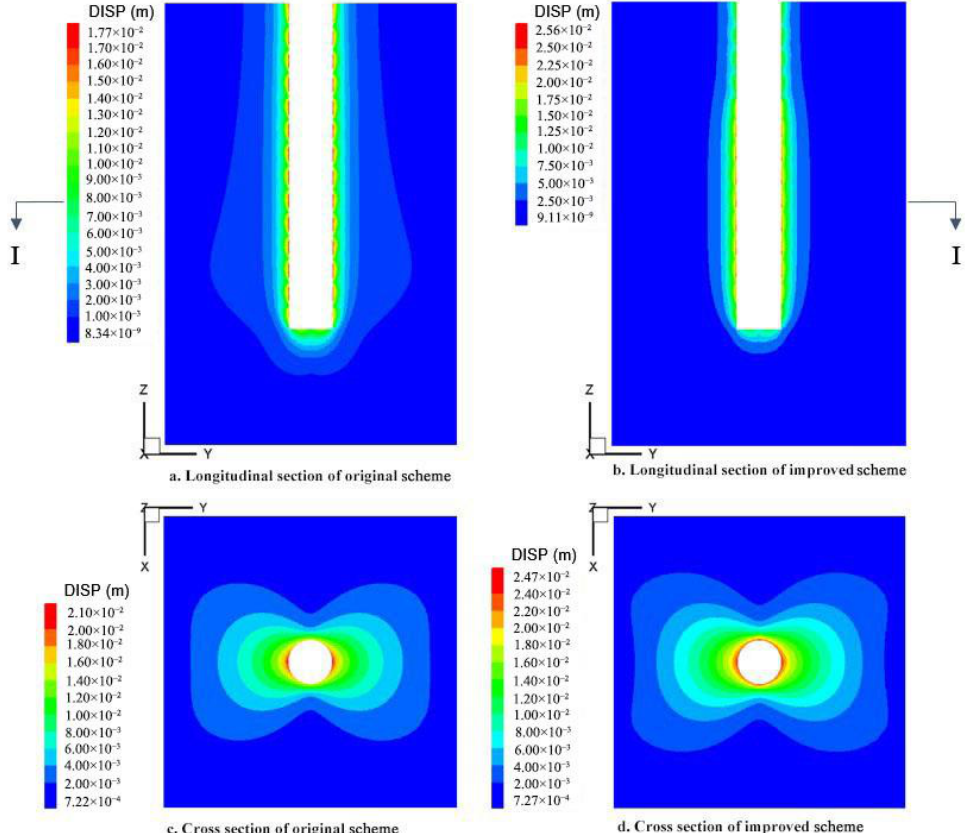
Figure 14. Ground displacement of different support construction schemes.